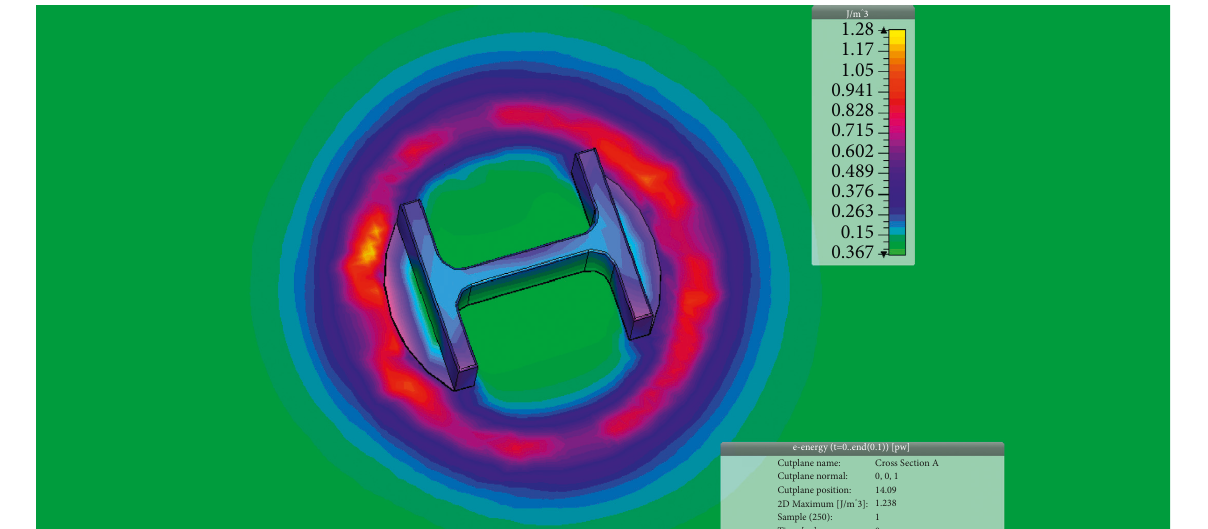
Figure 10: Electric field distribution on the detector surface.